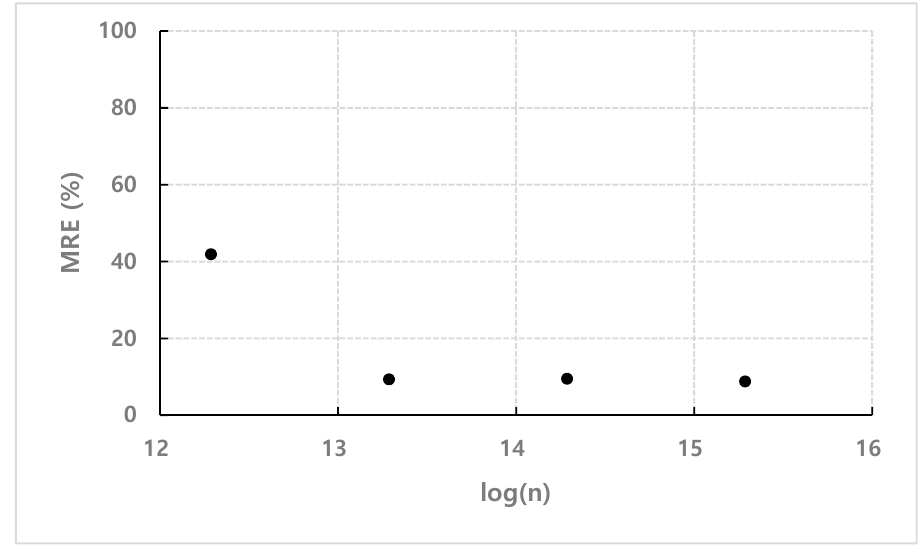
Figure 11. Mean relative errors (MRE) of experimental values according to the concentration and the values calculated by using the empirical coefficient C.